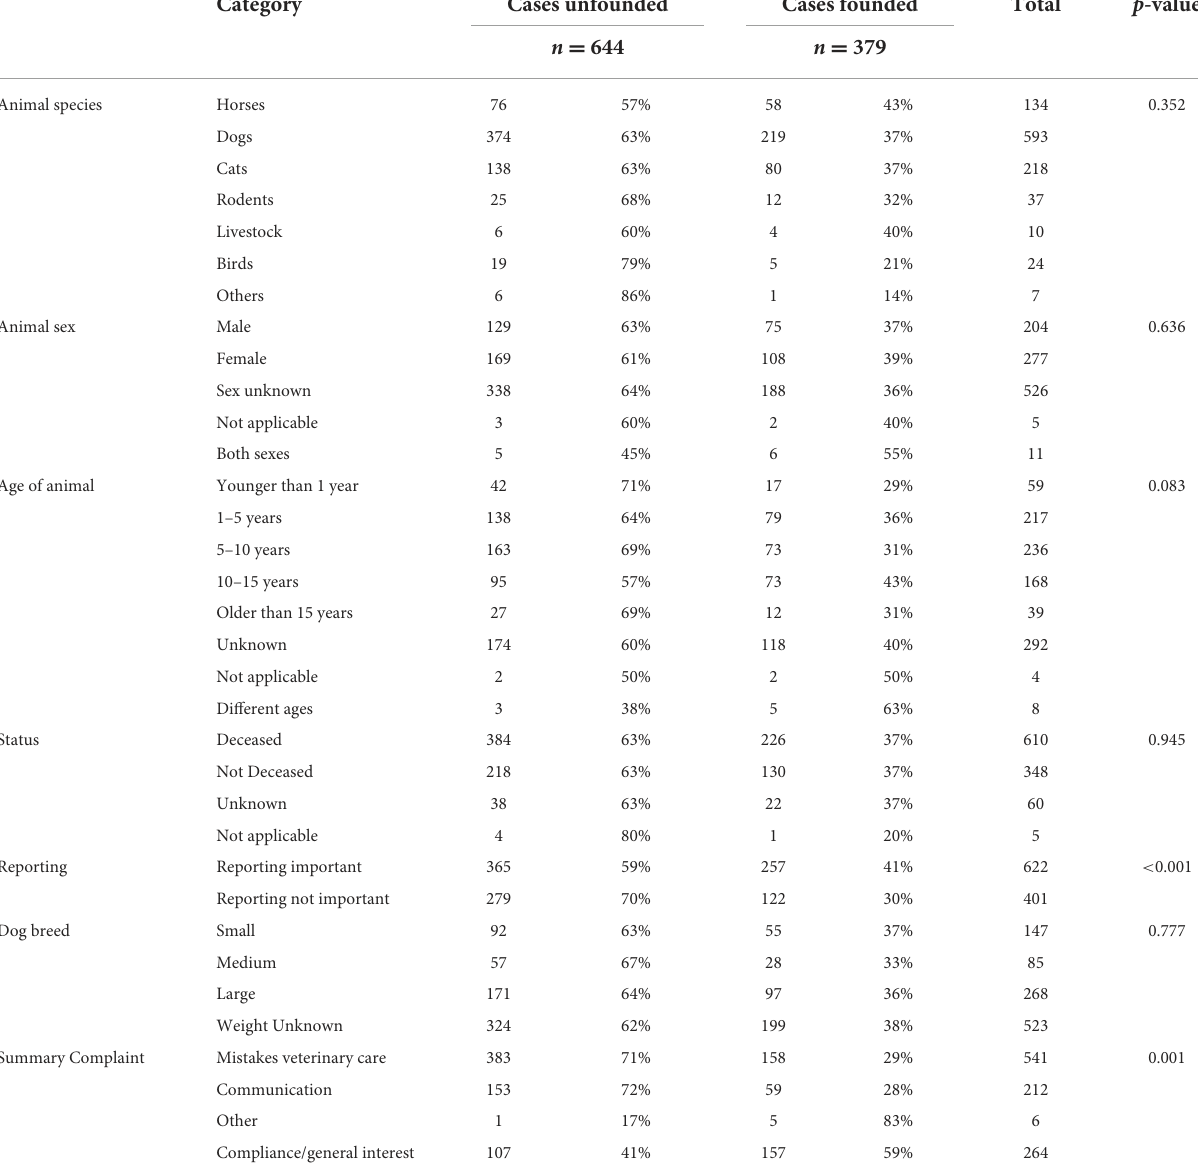
TABLE 4 Descriptive statistics of rulings addressing